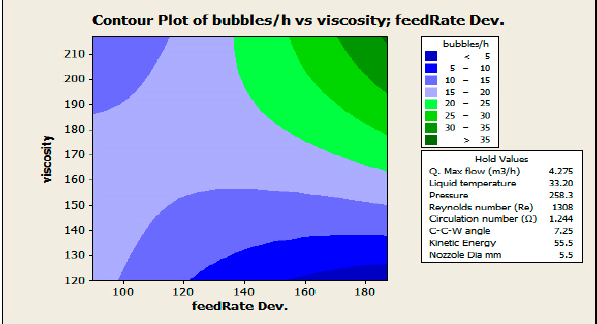
Figure 10. The contour plot of bubbles / h under Re, Ω .